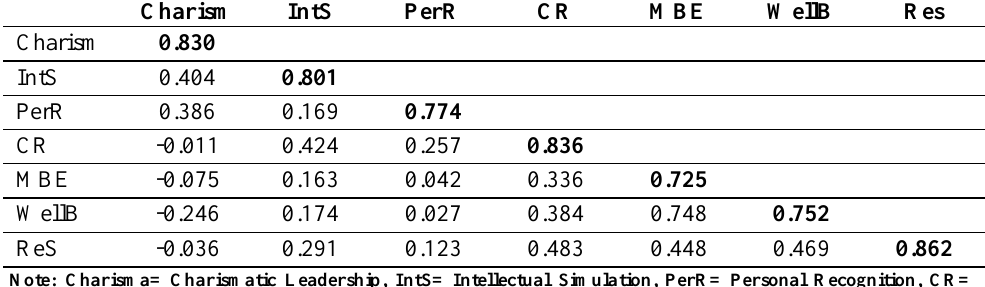
Table.3. Correlation of Latent Variables and Average Variance Extracted (AVE’s)